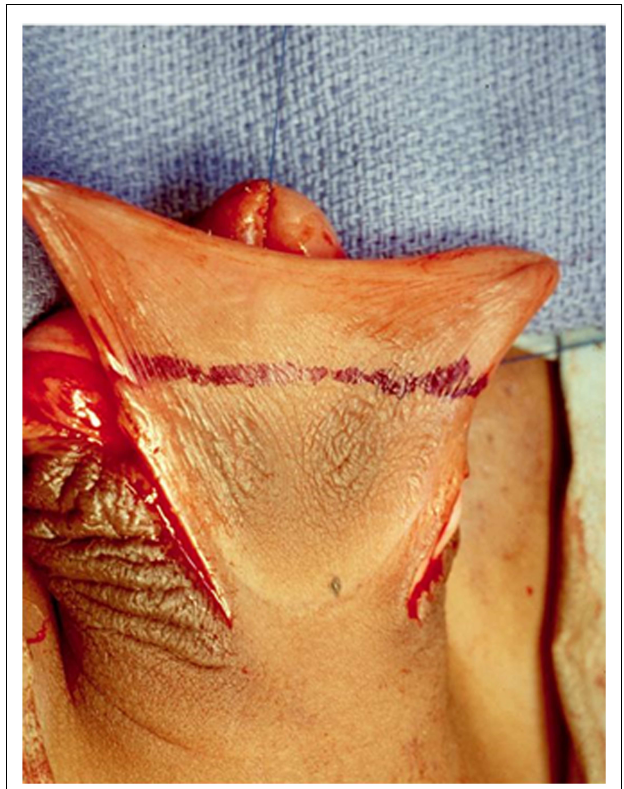
FIGURE 1 |After the penis is degloved, a superficial incision is made at the junction between the dorsal shaft skin and the prepuce (blue line). If there is some degree of scrotal transposition, superficial incisions are made to separate the scrotum from penile shaft.This is important to have enough dorsal skin and to correct the transposition.